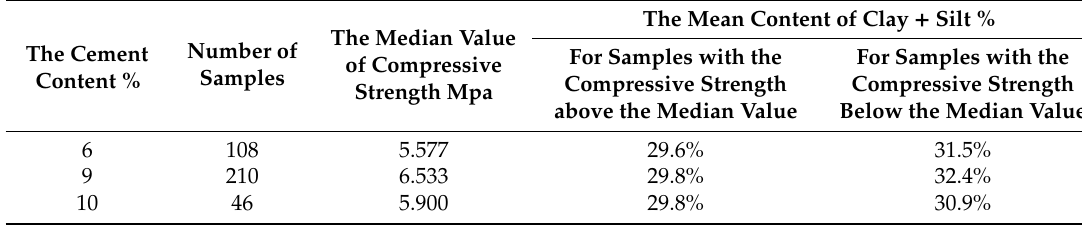
Table 5. The content of clay + silt for di ff erent groups of